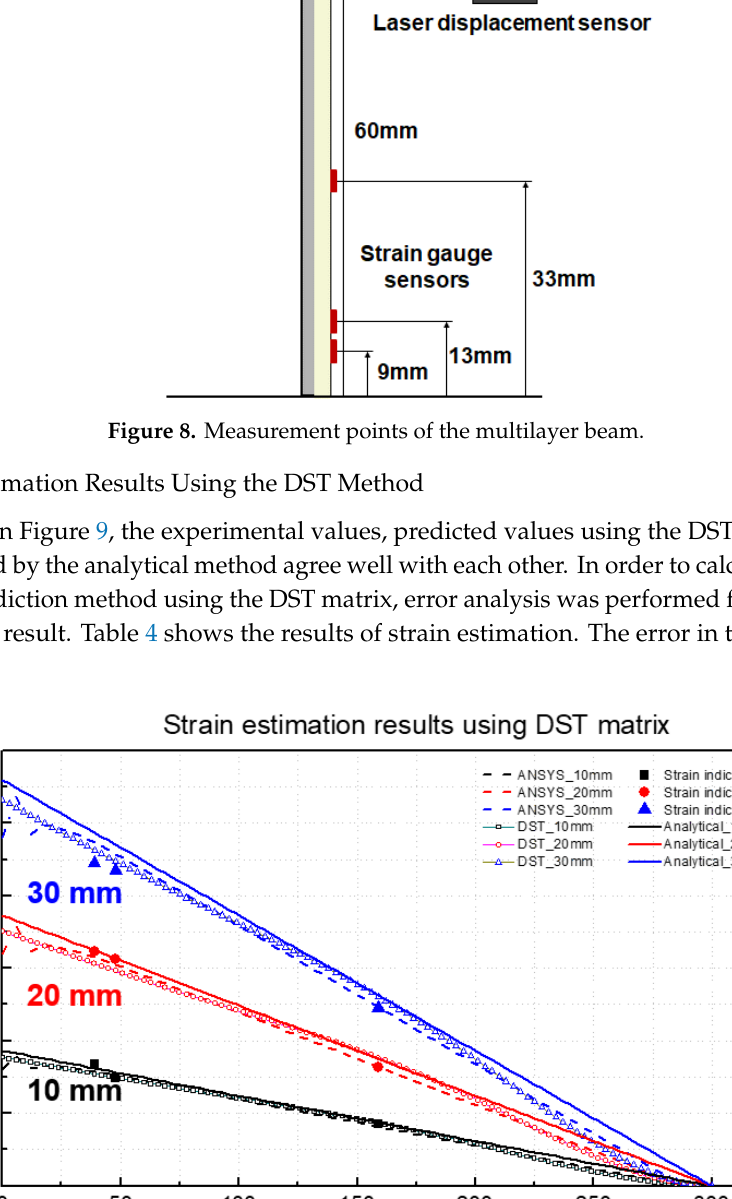
Figure 7. Test setup for displacement-to-strain transformation experiment.